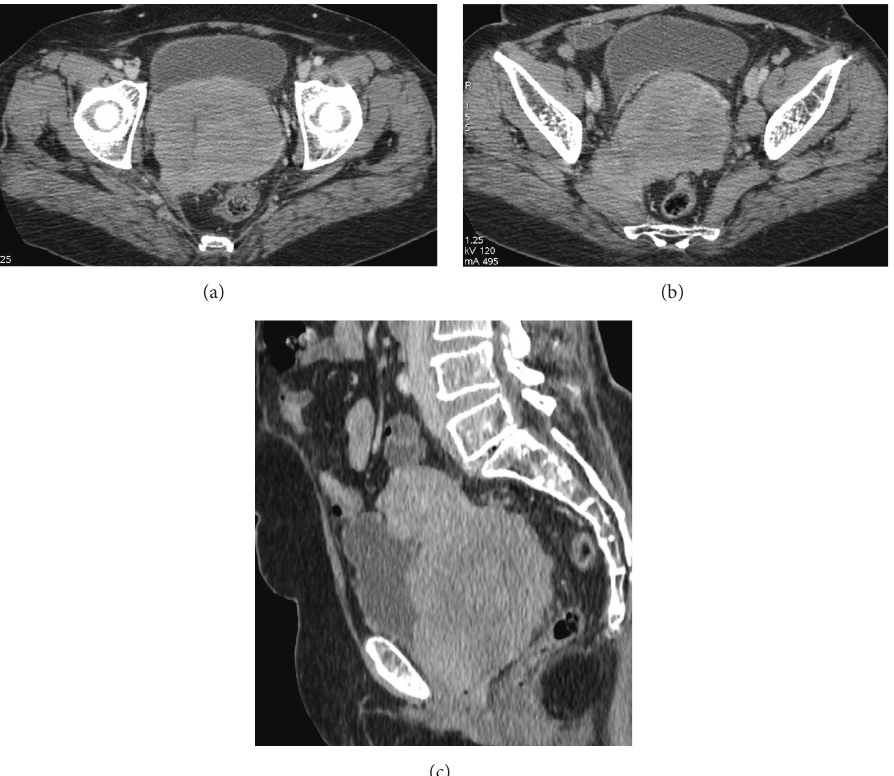
Figure 1: Prechemotherapy scan shows that an ill-defined enhancing lesion is seen involving the cervix invading the bilateral parametria (a) and uterus (c) and also extending into the right mesorectal fascia and piriformis muscle (b).